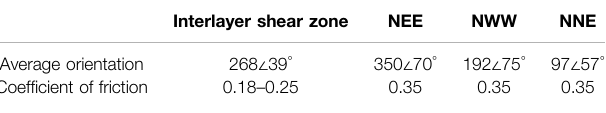
TABLE 2 | Physical and mechanical properties of the structural